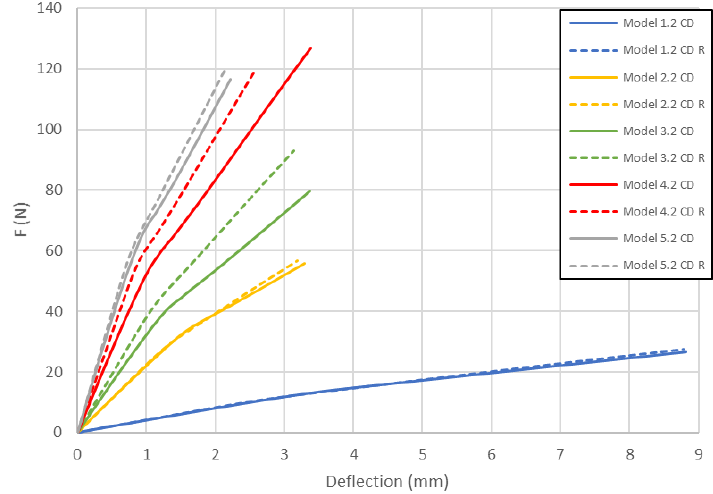
Figure 15. Comparison of curves of all considered cases in CD.